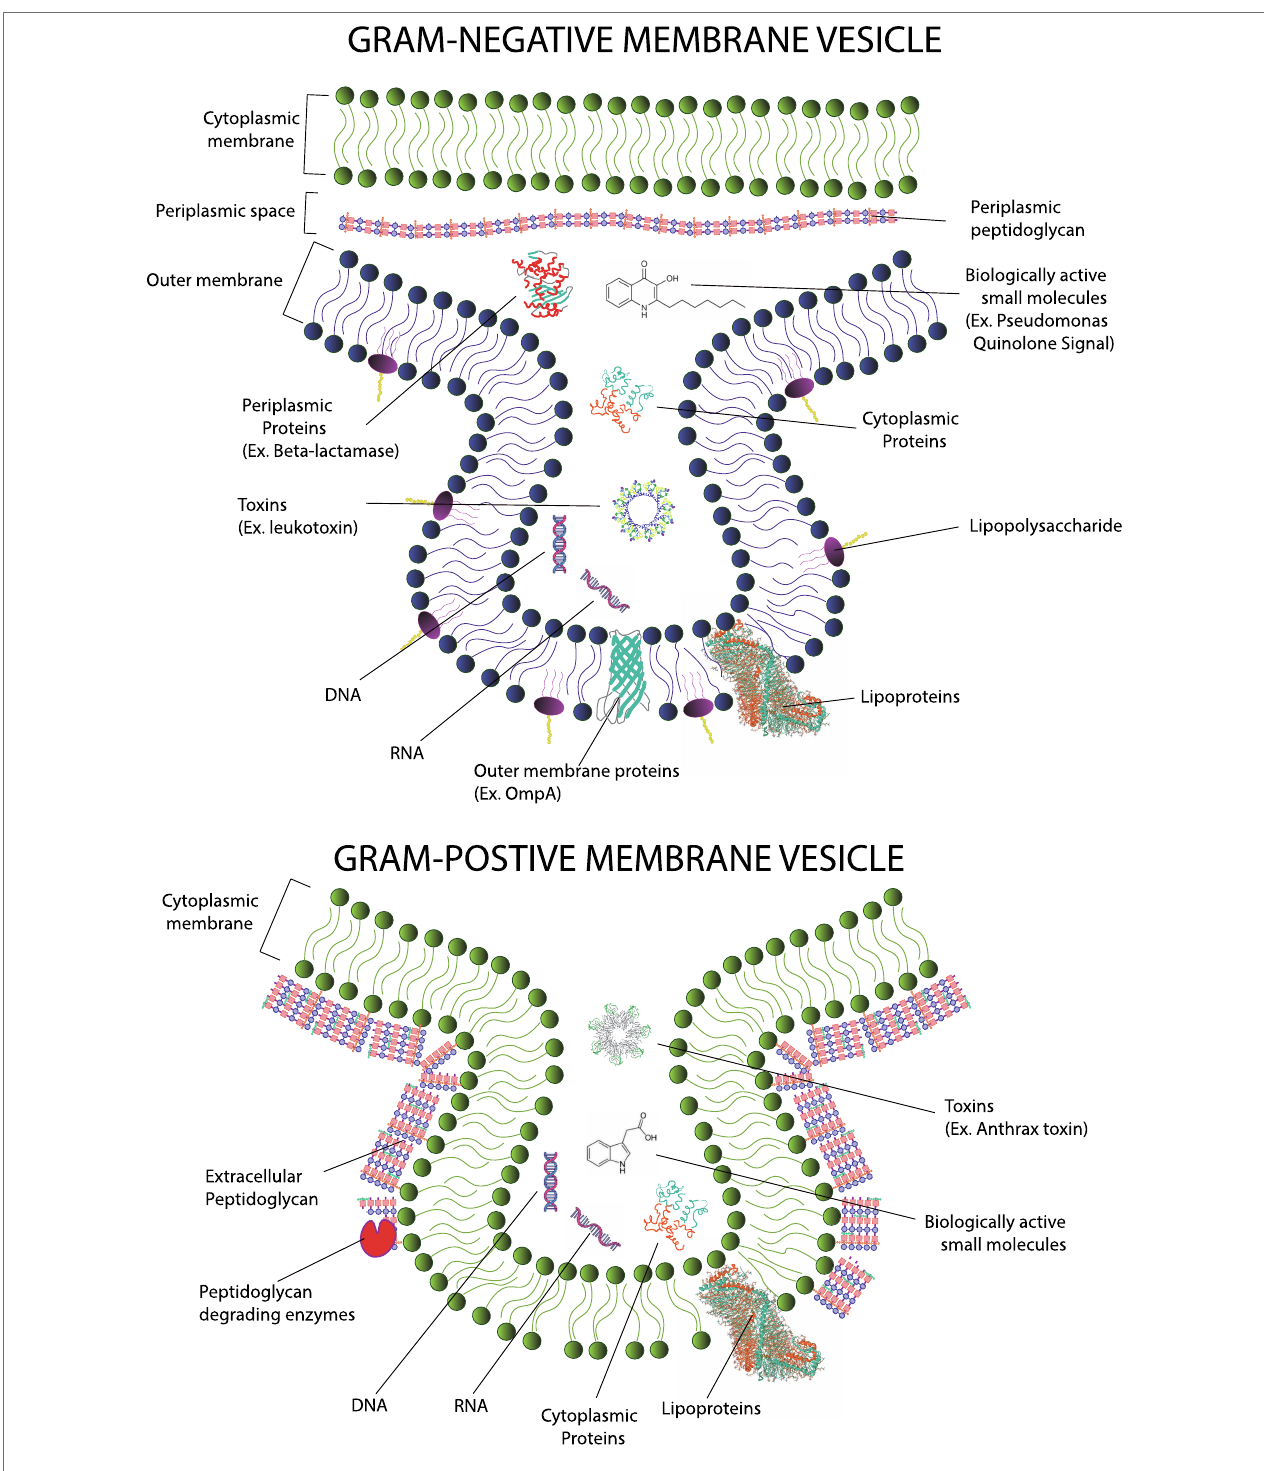
FIGURE 1 | Gram-positive membrane vesicles (MVs; top) form from the cytoplasmic membrane and encapsulate cytoplasmic material. In contrast, Gram-negative MVs (bottom) form primarily from the outer membrane and encapsulate material from the periplasmic compartment; however, contributions from the cytoplasm and cytoplasmic membrane have been reported in Gram-negative species. Mechanisms of MV formation differ and mechanisms of Gram-positive MV formation must overcome an outer layer of peptidoglycan. Gram-negative MVs and Gram-positive MVs carry similar cargos including genetic information, proteins (including toxins and enzymes) as well as small molecule messengers. However, because of evolutionary divergence, specific types of molecules are not shared. For example, LPS and many types of outer membrane proteins are found only in Gram-negative